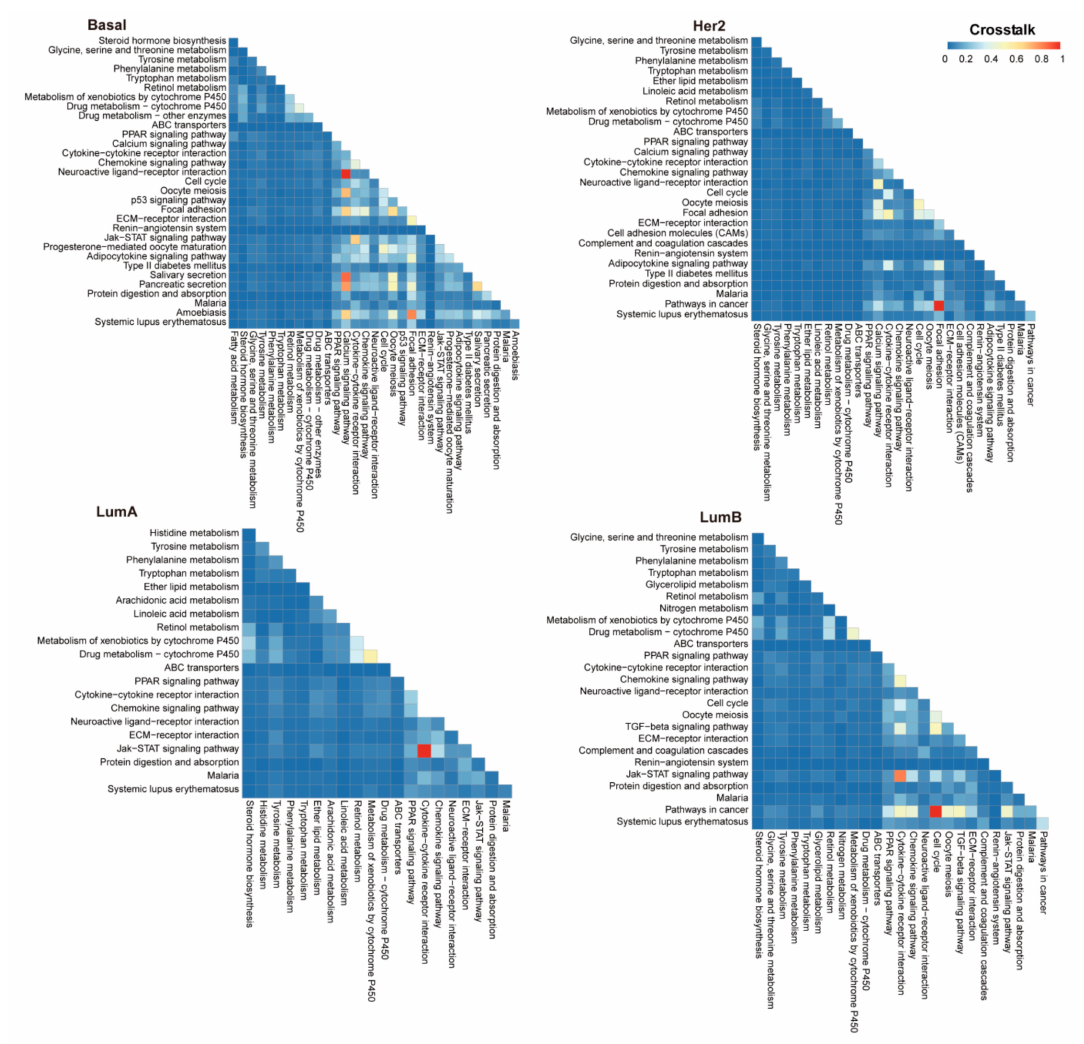
Figure 3. The crosstalk for each two interrelated risk pathways in breast cancer subtypes. Heat maps of crosstalk between risk pathways for comparing the heterogeneity of crosstalk across di ff erent subtypes of breast cancer. The color of the box represents the crosstalk between the two pathways, the lower and higher crosstalk are represented by blue and the red colors,